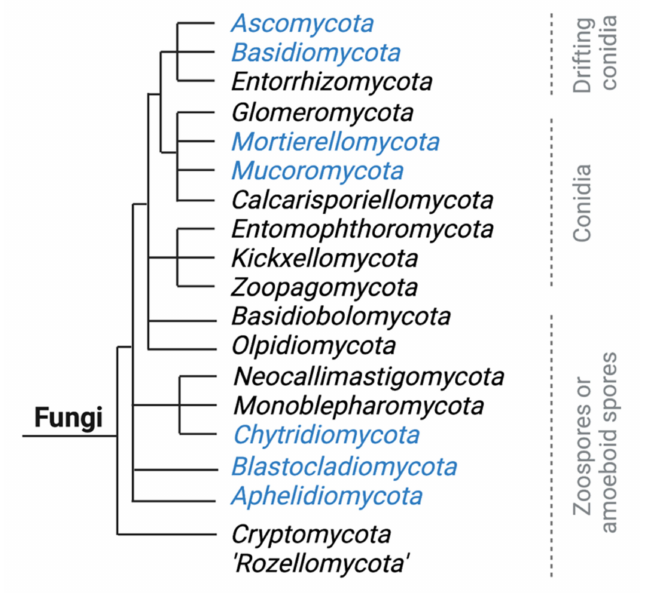
Figure 3. Fungal tree of life including the updated phylum-level classification of fungi, illustrating the morphological characteristics of the spores that are adapted for dispersal in marine habitats. Phyla which contain marine fungal lineages are depicted in